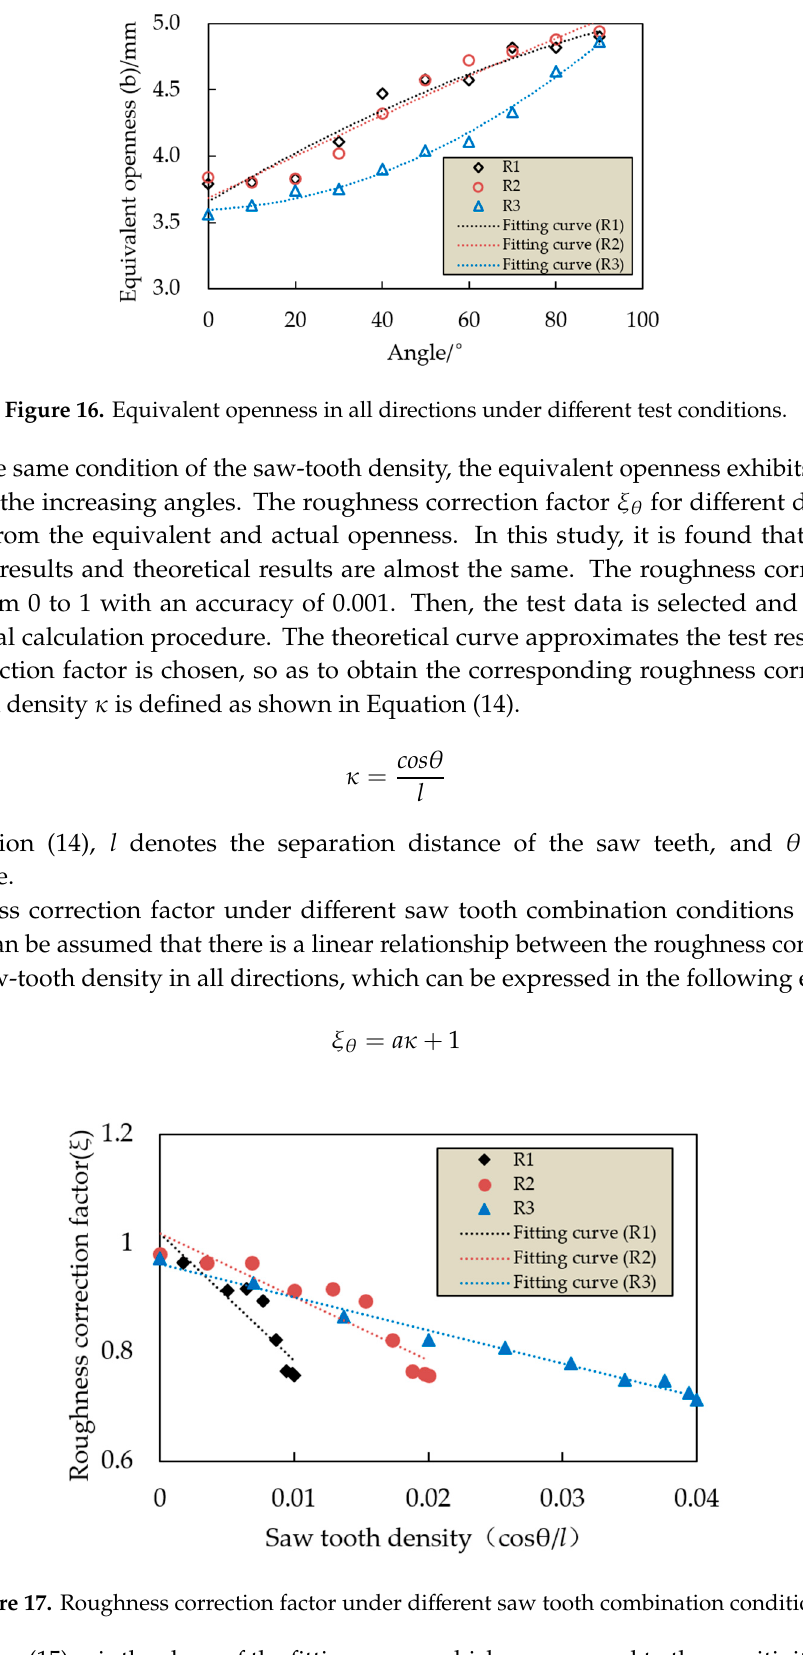
Figure 17. Roughness correction factor under different saw tooth combination conditions.